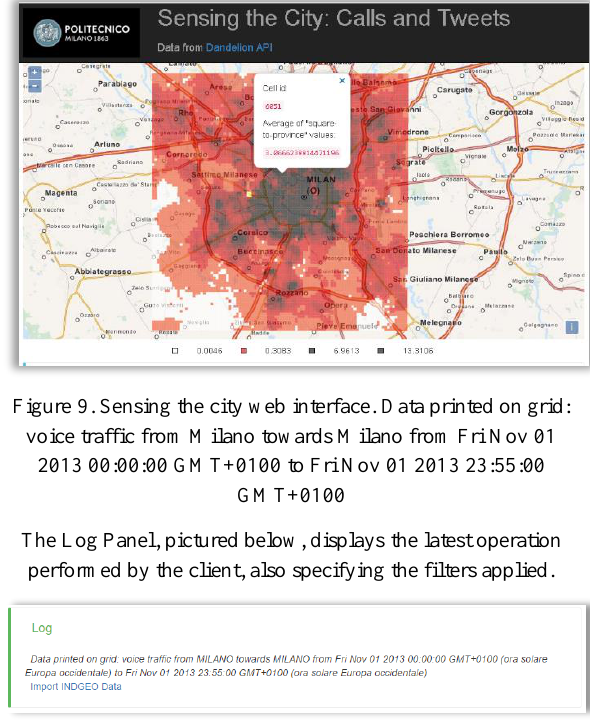
Figure 10. Client’s log